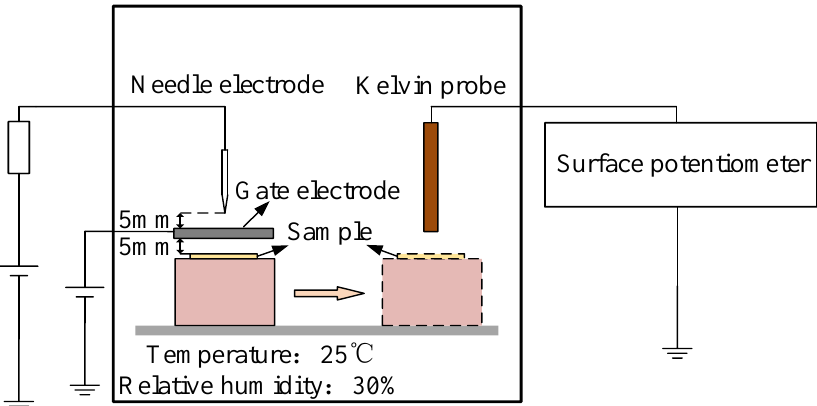
Figure 3. Schematic diagram of corona and surface potential measurement system.